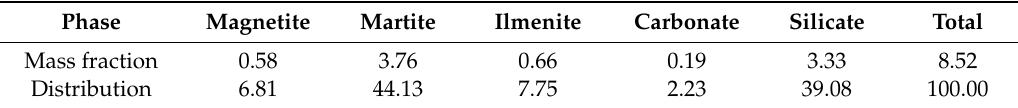
Table 3. Chemical phase analysis of iron in raw sample (wt %).